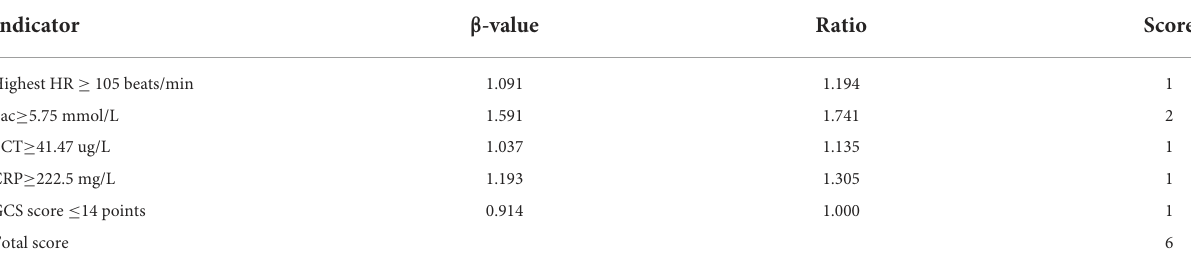
TABLE 5 Coefficients and scores of diagnostic indicators of septic shock in patients with DTP.